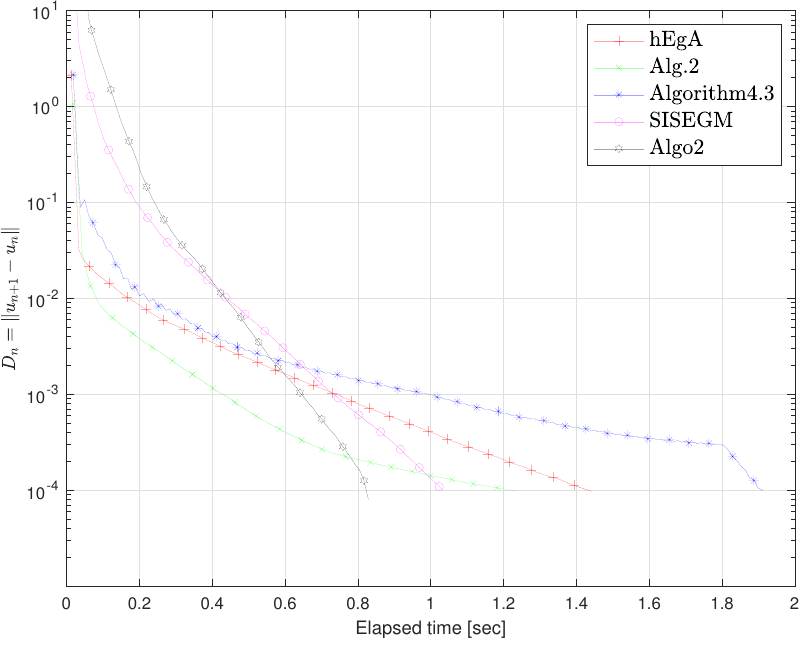
Figure 10. Example 1 in R 5 : Elapsed time 1.44, 1.23, 1.97, 1.03, 0.84 respectively.